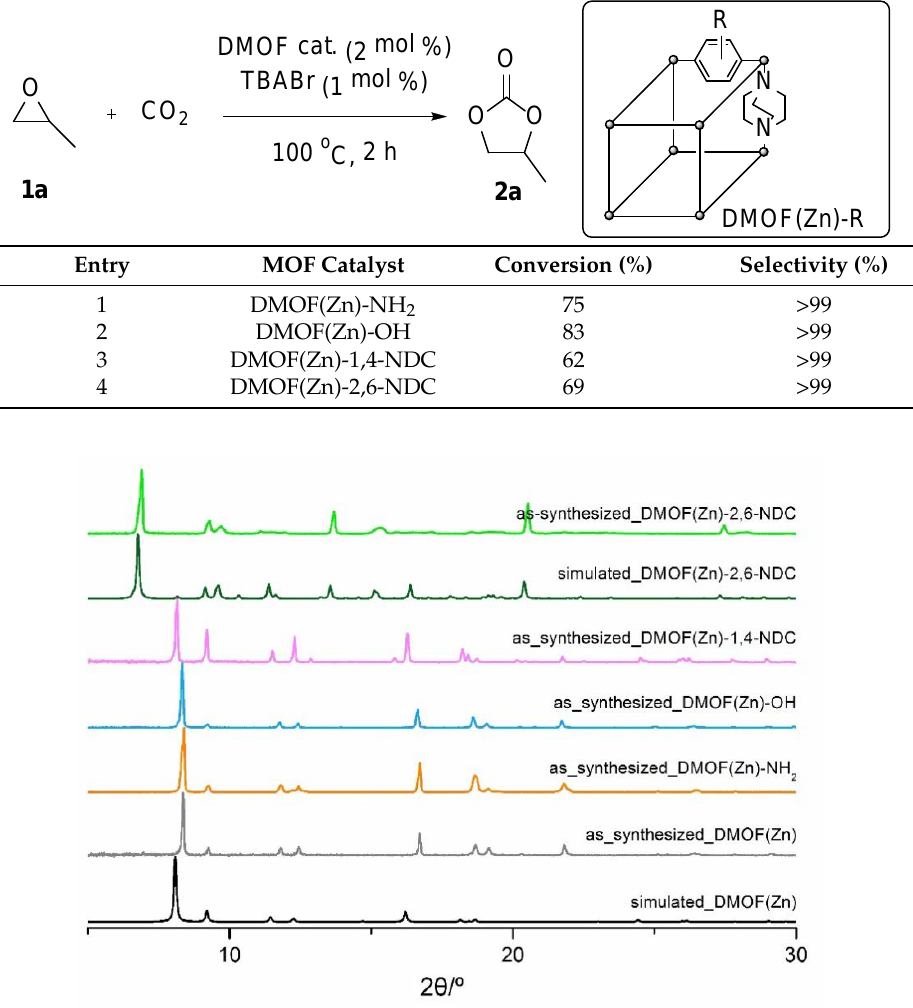
Table 2. Functional group controls in DMOF(Zn)s.